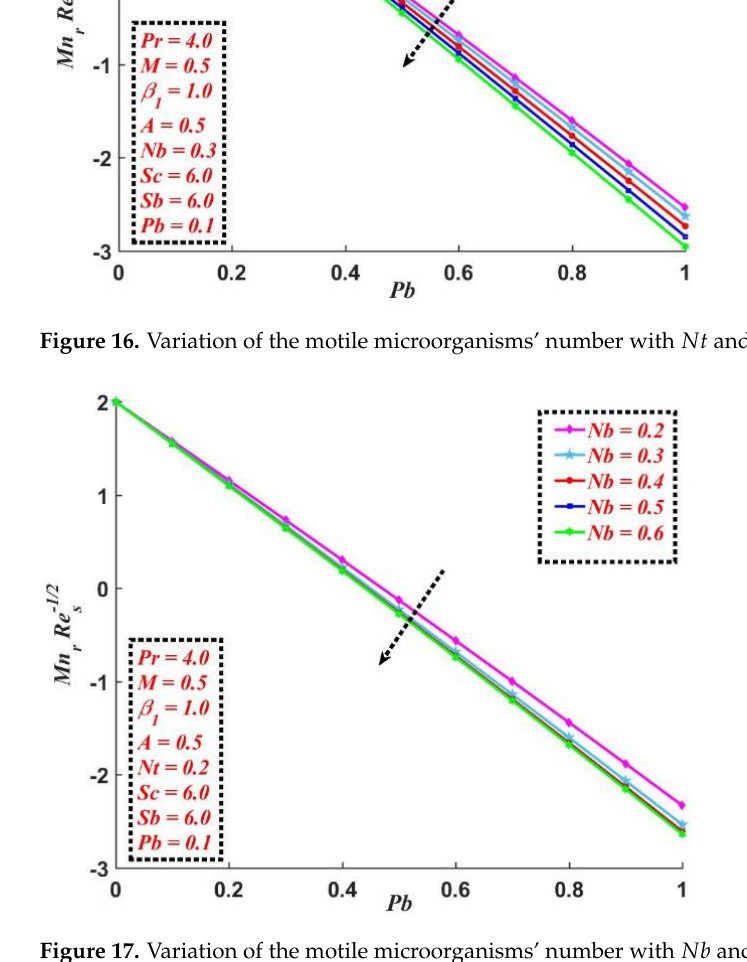
Figure 17. Variation of the motile microorganisms’ number with Nb and Pb .